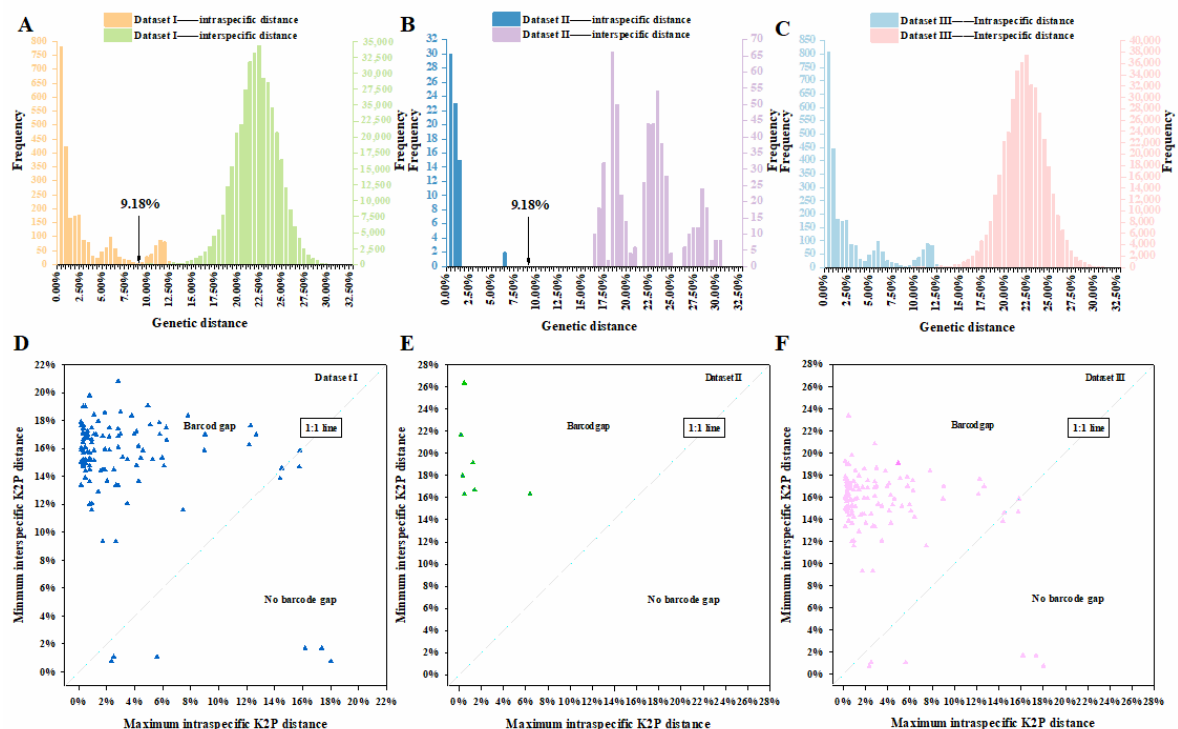
Figure 2. Intra- and inter-GD histograms of dataset I ( A ), dataset II ( B ), and dataset III ( C ). The marked 9.18% indicates a suggested delimitation genetic distance threshold for most Entiminae; ( D – F ) Scatter plot of the max intra-GD versus min inter-GD for the corresponding dataset above. Each triangle represents a species. The dot falling below the 1:1 slope indicating the absence of a “barcode gap”.